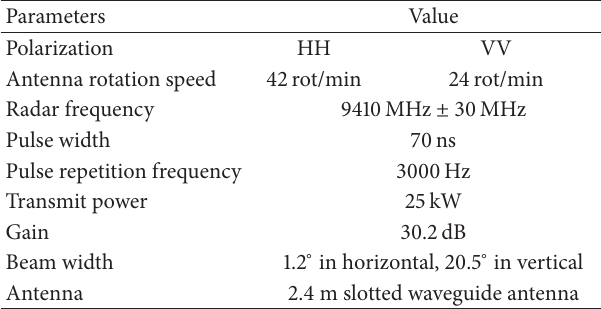
Table 1: Configurations of the X-band marine radar